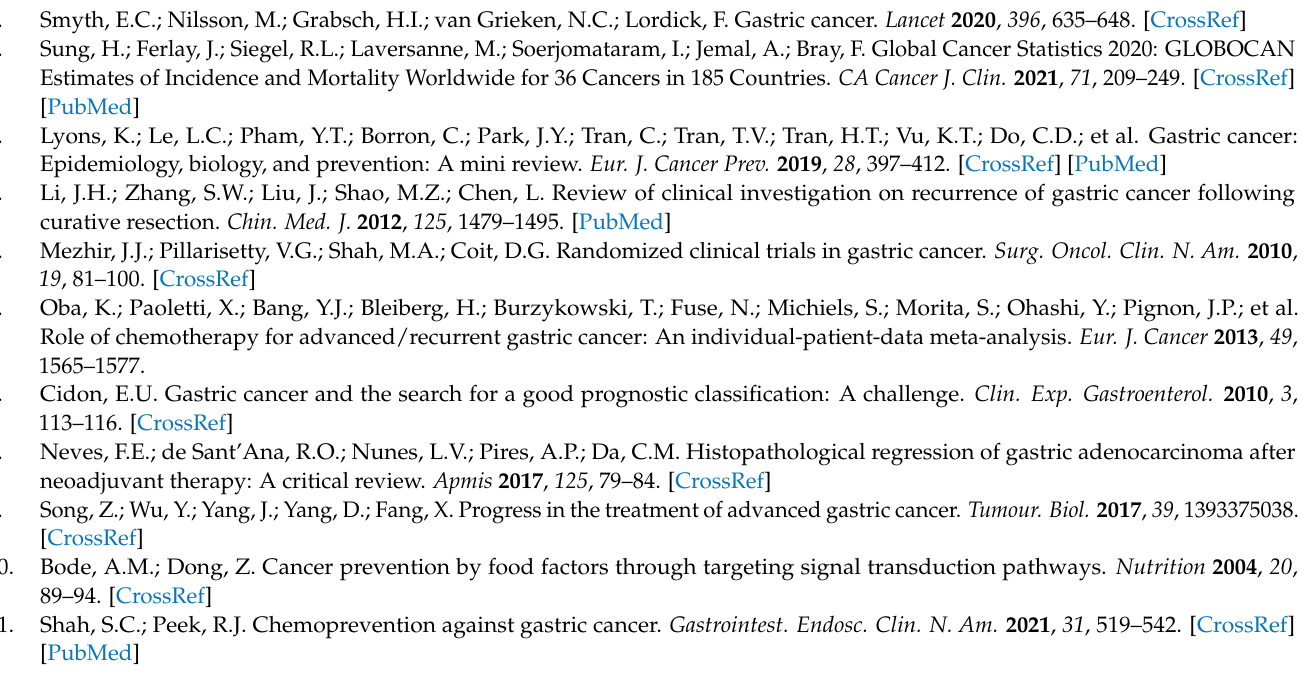
Original blots of Figure 2. Figure S7: Original blots of Figure 3. Figure S8: Original blots of Figure 4. Figure S9: Original blots of Figure 5. Figure S10: Original blots of Figure 6. Figure S11: Original blots of Figure